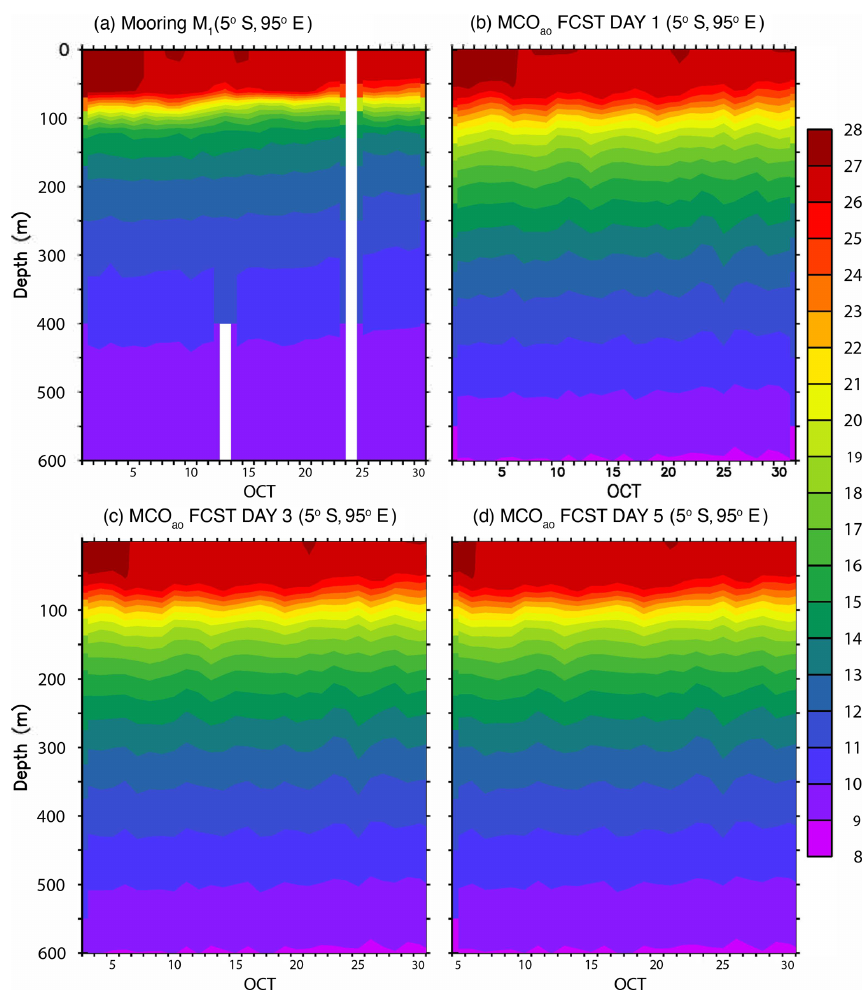
Figure 9. Depth–time plots of temperature ( ◦ C) at the M 1 mooring location from (a) buoy observations and model forecast (b) fcst_day1, (c) fcst_day3, and (d) fcst_day5. The x axis starting date is different between (c) and (d) .